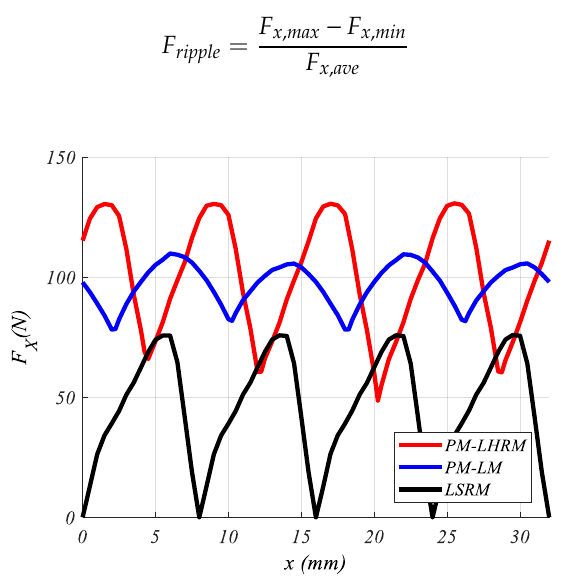
Figure 10. Phase force profiles and total force. ( a ) PM-LM at shift = 4 mm. ( b ) PM-LHRM at shift = 4 mm.